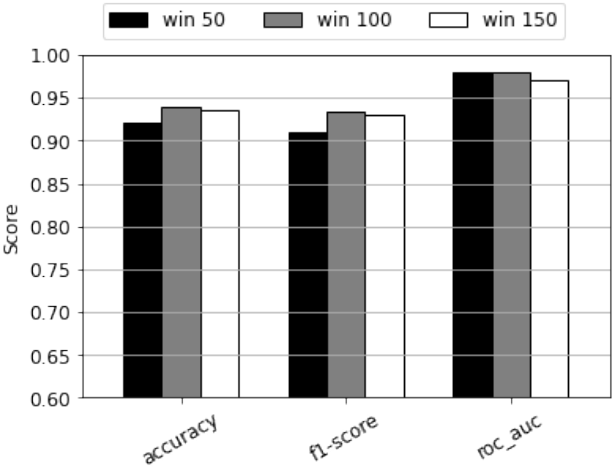
Figure 9. LSTM-RF detection results for various window